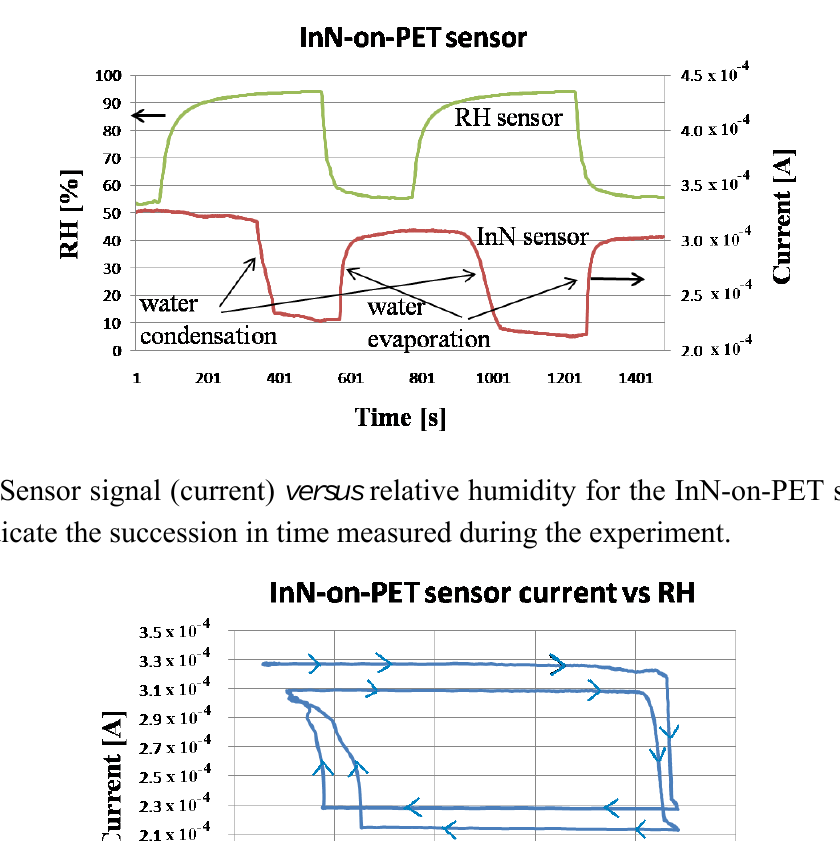
Figure 5. Current behavior during water condensation and evaporation for the InN-on-PET sensor.